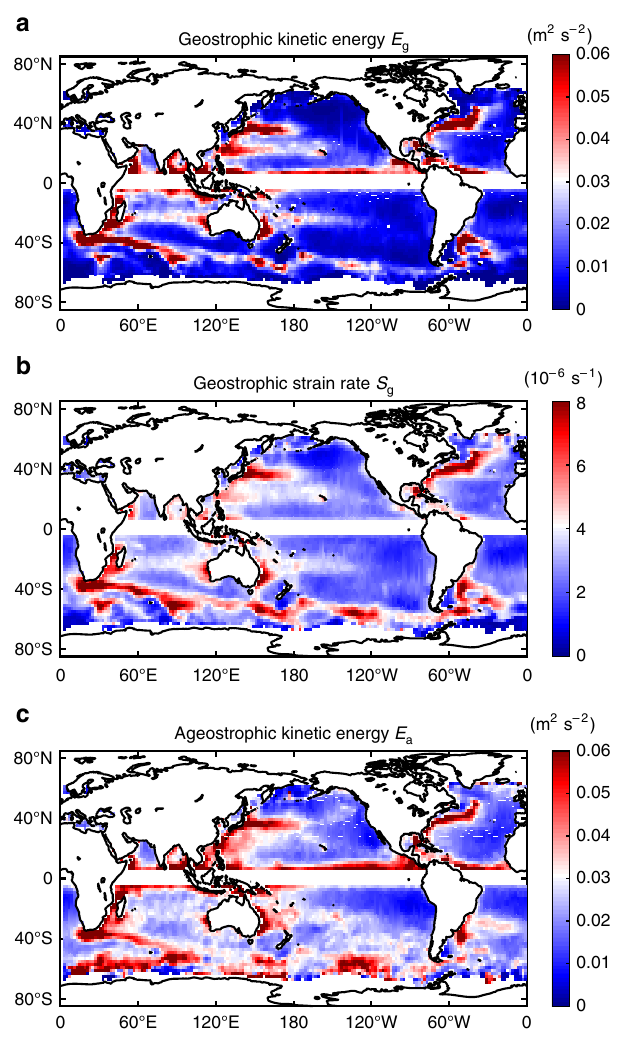
Fig. 1 Global distributions of mean energies and strain rate. a Geostrophic kinetic energy E g . b Geostrophic strain rate S g . c Ageostrophic kinetic energy E a . All maps are constructed by averaging with 3° × 3° moving window at each grid point for all available data points. Notice that the geostrophic kinetic energy E g and strain S g are computed by using the altimeter data, whereas the ageostrophic kinetic energy E a is derived from the drifter-observed absolute surface velocity data in combination with the altimeter data (see Methods). Source data are provided as a